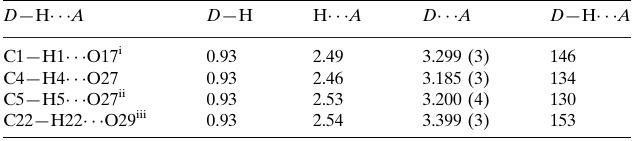
Hydrogen-bond geometry (A˚ , (cid:4) ).